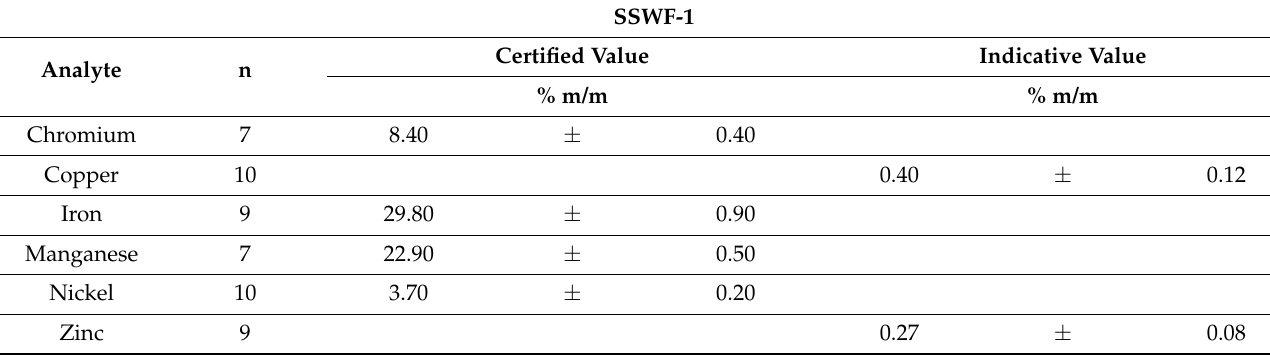
Table A3. Mass fraction (% m/m) for analytes in the Health and Safety Executive (HSE) SSWF-1 and MSWF-1 adapted from